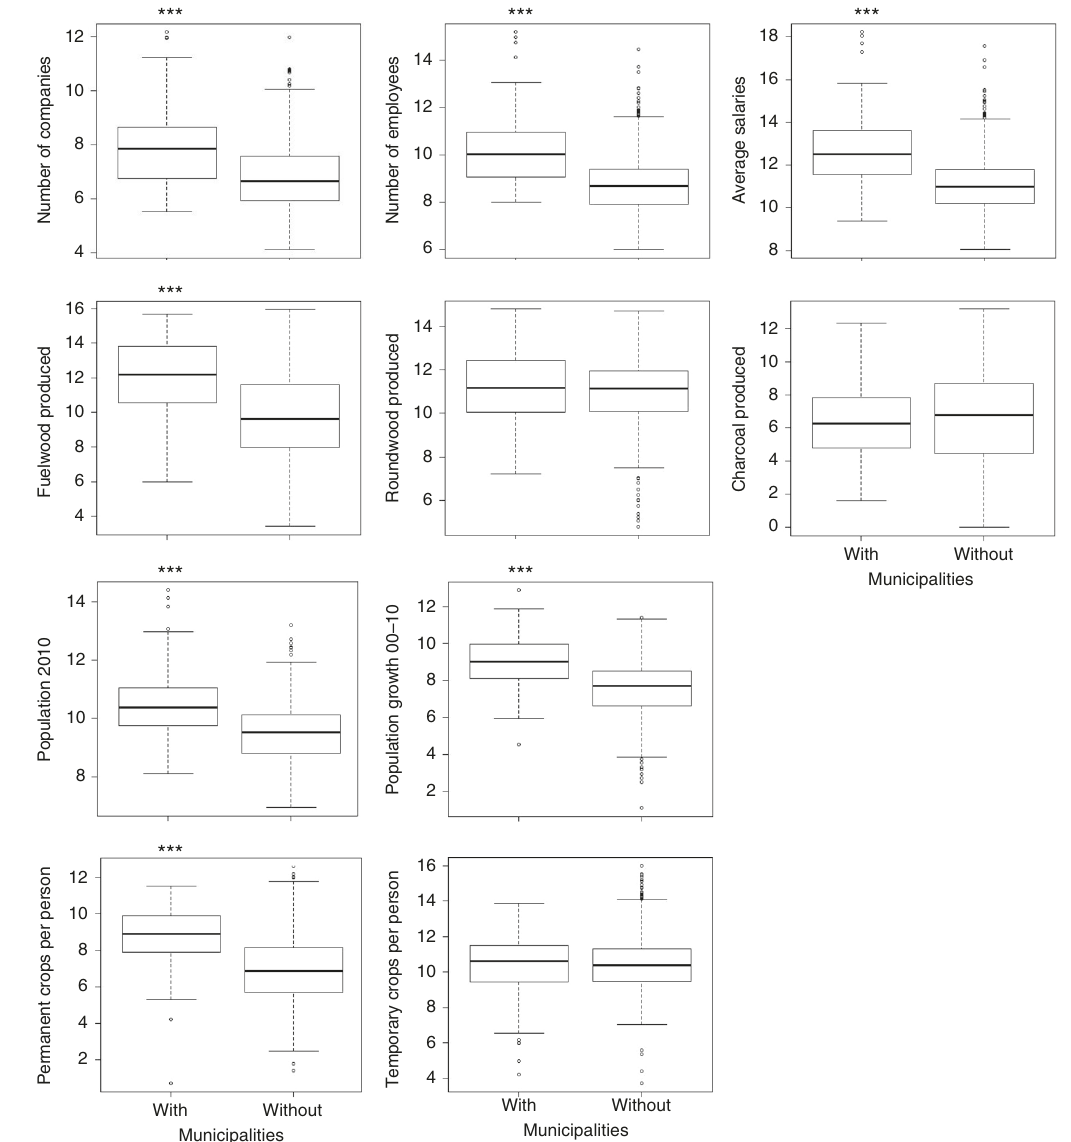
Fig. 3 Socio-economic variables of municipalities with mining leases verses those without. All response variables have been log-transformed. Stars denote signi fi cant differences (Wilcoxon ’ s rank-sum tests; *** P < 0.001). Note : the quantity of fuelwood, roundwood, and charcoal produced (second row) excludes silviculture. All data sets are described in Supplementary Table